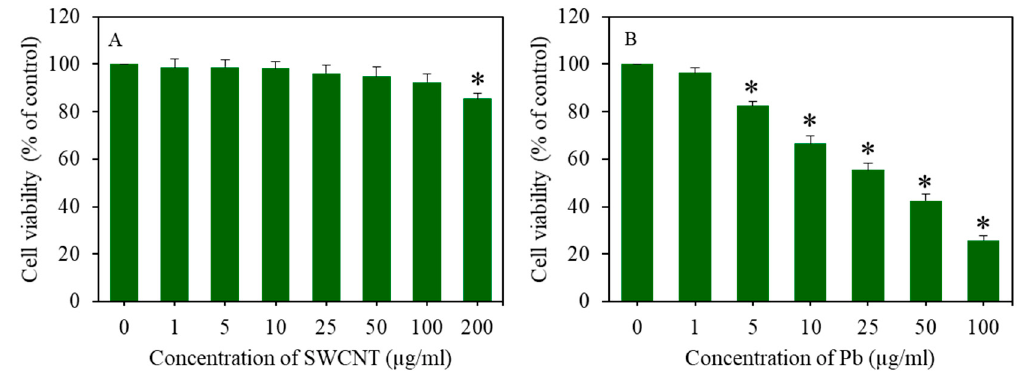
Figure 2. Cell viability of A549 cells after exposure to various concentrations of SWCNTs and Pb for 24 h. ( A ) Cell viability after SWCNT exposure and ( B ) cell viability after Pb exposure. Data provided as mean ± SD of three identical experiments made in three replicates. * Significantly different from the control group ( p < 0.05). SWCNTs: Single-walled carbon nanotubes, Pb: Lead, A549 cells: Human lung cells.